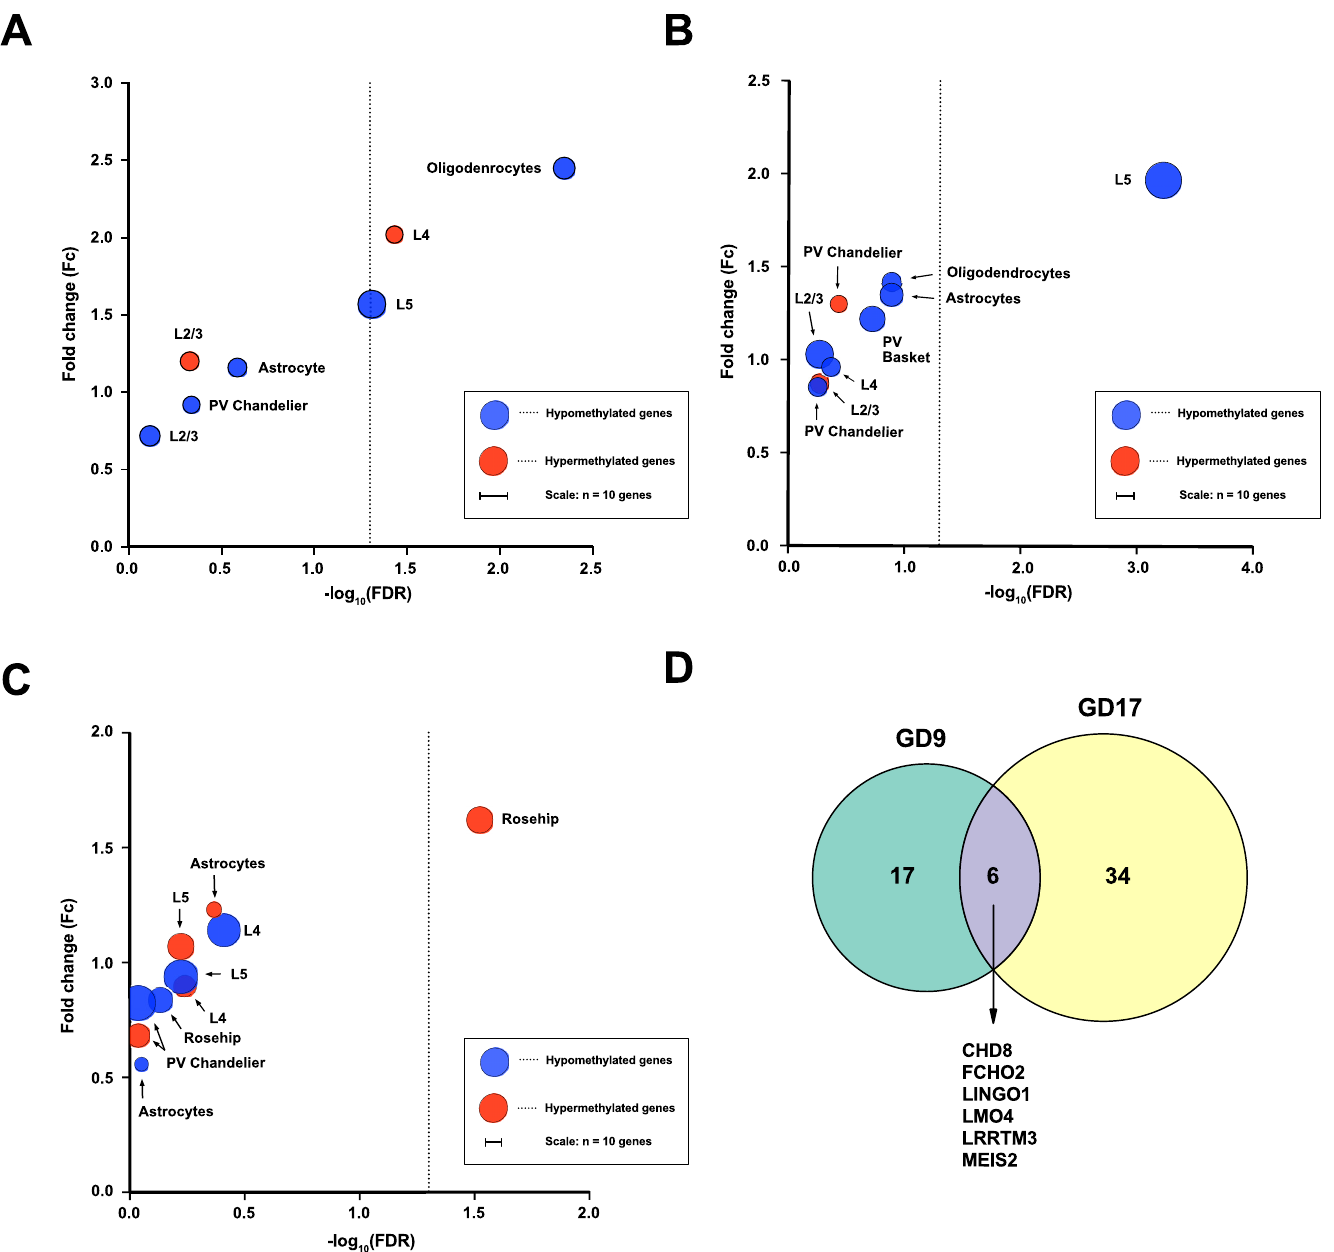
Fig 1. Enrichment of differentially expressed genes amongst differentially methylated foetal genes in cell subpopulations following MIA at different gestational timepoints. (A) Enrichment of upregulated genes among differentially methylated foetal genes following MIA at GD9. Size of the circles represents the number of overlapping genes. The dashed line is set at FDR = 0.05. (B) Enrichment of upregulated genes among differentially methylated foetal genes following MIA at GD17. Size of the circles represents the number of overlapping genes. The dashed line is set at FDR = 0.05. (C) Enrichment of downregulated genes among differentially methylated foetal genes following MIA at GD17. Sizes of the circles represents the number of overlapping genes. The dashed line is set at FDR = 0.05. (D) The intersect of enriched genes differentially methylated following MIA at both GD9 and GD17.